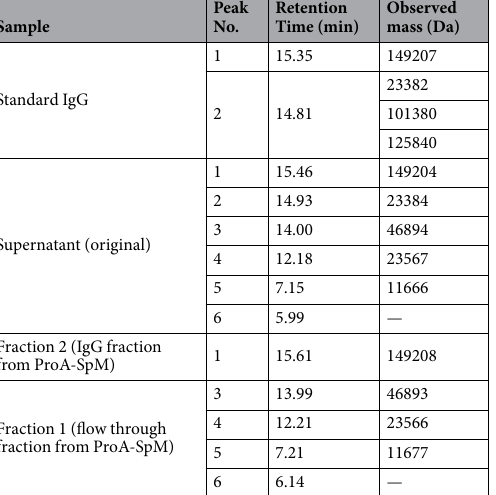
Table 1. Peak identifications from a protein A load sample. Fractions 1 and 2 were collected from the separation (Fig. 1(j)) from the front and back peaks, respectively. The peaks are corresponding to Fig. 1(k). The observed mass was estimated by a deconvolution of multi ions with MaxEnt1.